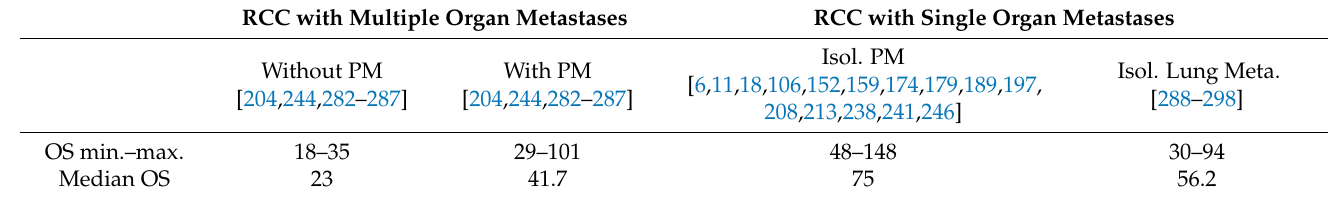
Table 5. Influence of PM on OS (months) in mRCC with multi-organ sites and single organ site metastases. RCC with Single Organ